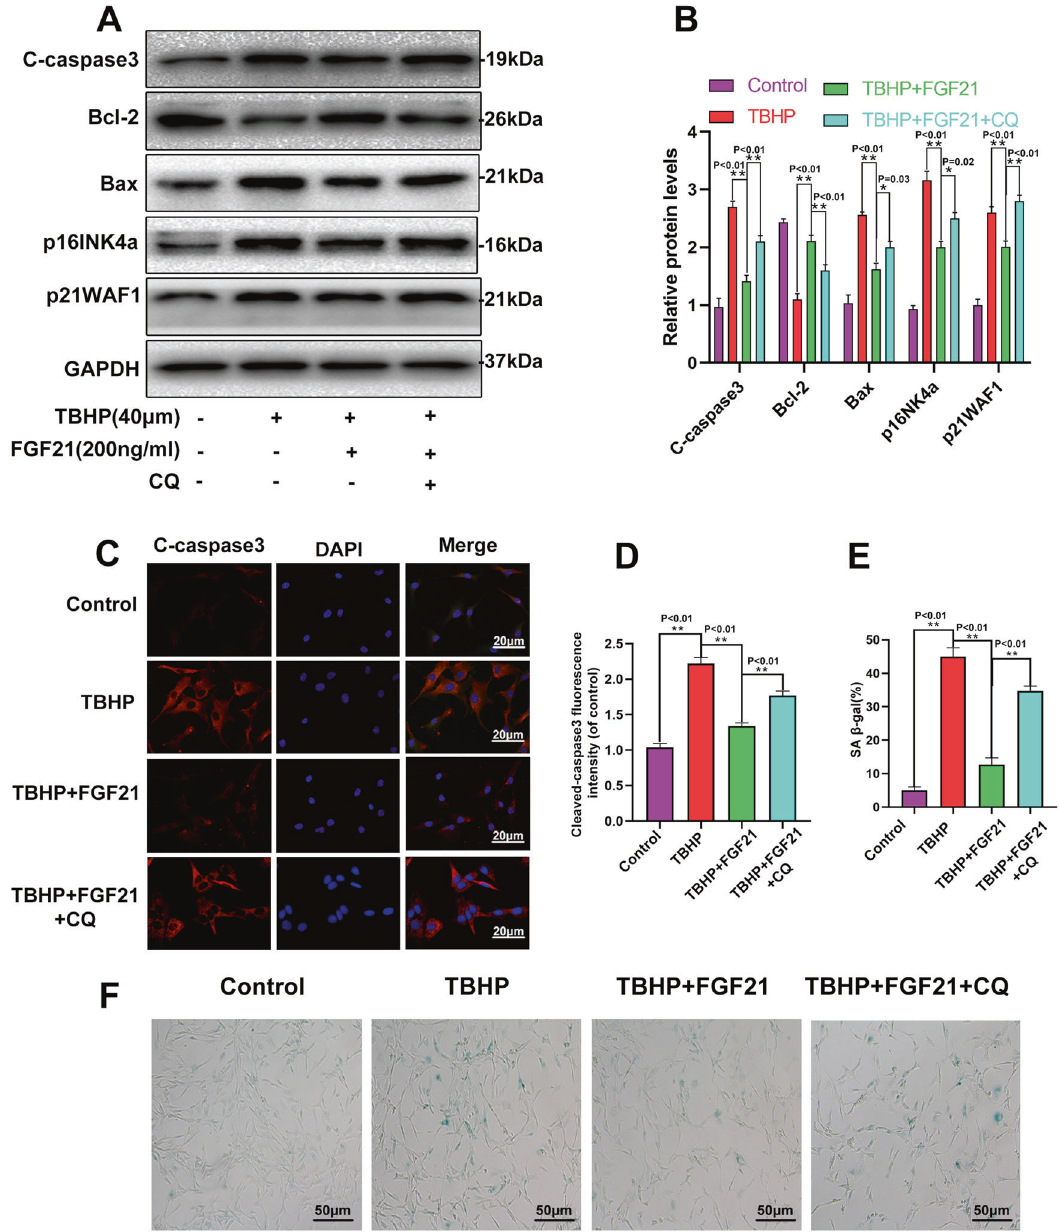
Fig. 4 CQ reversed the effect of FGF21 on the apoptosis and senescence of chondrocytes under oxidative stress. A , B Shown is the protein expression of C-caspase3, Bax, Bcl-2, p16INK4a, and p21WAF1 in the chondrocytes treated as above. C , D The immuno fl uorescence analysis of C-caspase3 proteins in the chondrocytes as treated above (scale bar: 20 μ m). E , F The SA- β -gal staining assay was performed in the chondrocytes as treated above (scale bar: 50 μ m). The data in the fi gures are the averages ± S.D. Signi fi cant differences between the treatment and control groups are indicated as ** P < 0.01 and * P < 0.05, n =